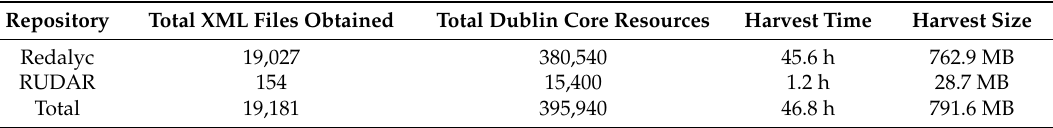
Table 2. Results of the OAI-PMH harvesting